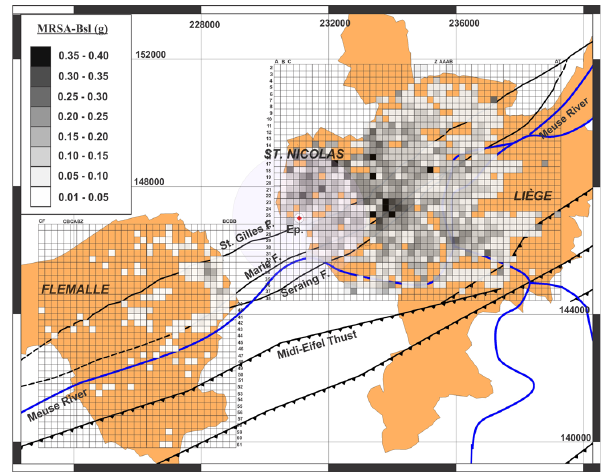
Fig. 9. Geographical distribution of MRSA (period ∼ 0.3s) during the 1983 Li ` ege earthquake estimated applying Bsl fragility curve to the damaged building located in different square areas defined for the localities of Saint Nicolas, Li`ege and Fl´emalle. Projections: Belgian Lambert